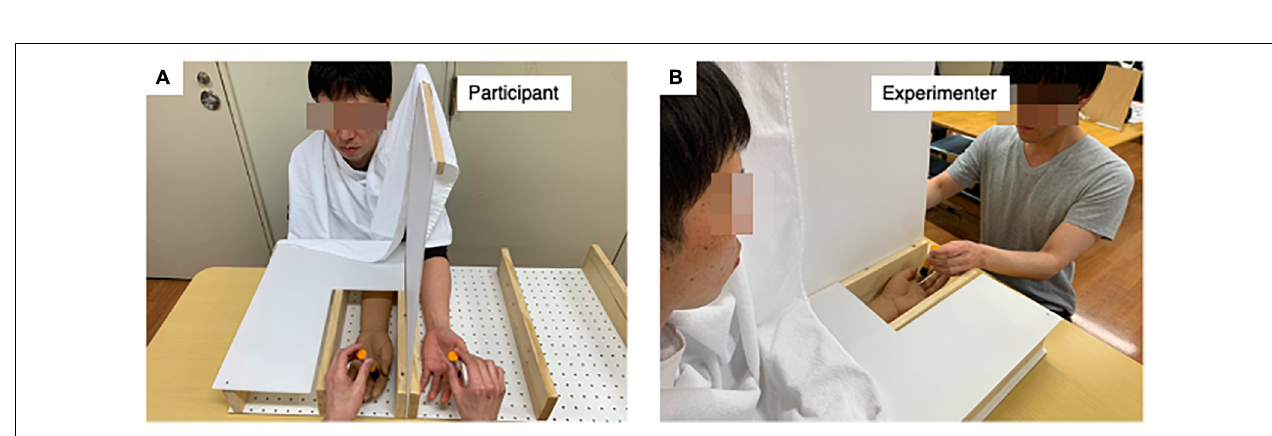
FIGURE 2 | Settings of the rubber hand illusion (RHI). (A) Settings of the RHI from the experimenter’s viewpoint. The RHI box is a (450 mm long × 900 mm wide × 100 mm high) made of wood and plastic materials. (B) Presentation of the RHI stimuli from the subjects’ viewpoint.